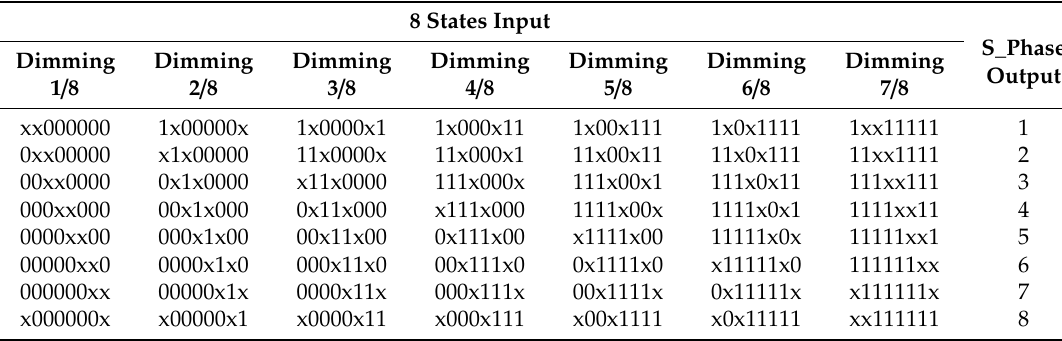
Table 3. S_Phase value definition for the captured set of unclear LED group states under dimming condition (Adapted from [30]).